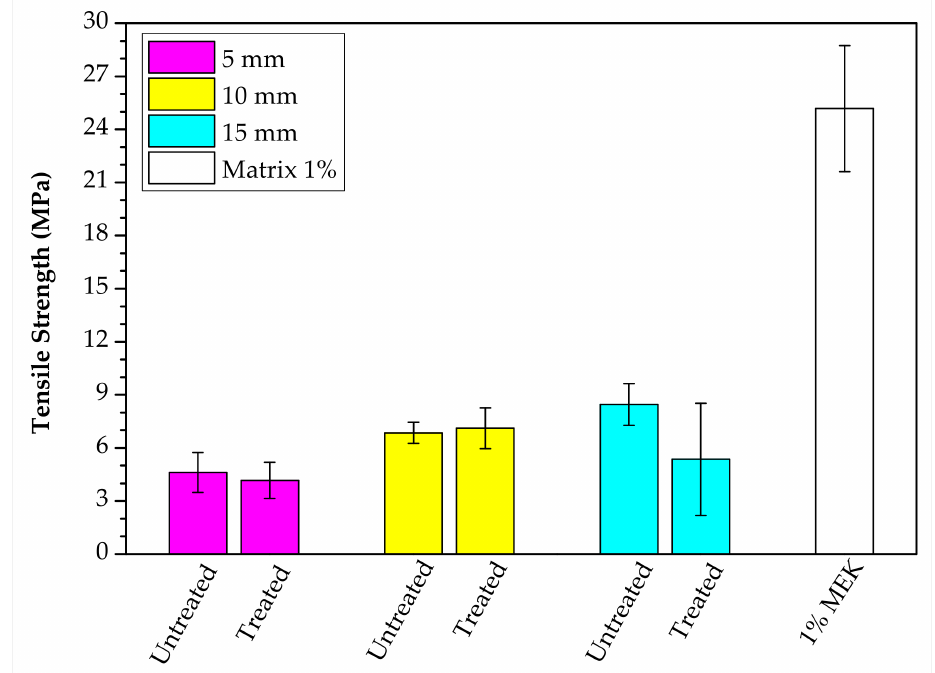
Figure 8. Tensile strength of ra ffi a fiber composites under alkali treated and untreated conditions, with 5, 10, and 15 mm of fiber length.